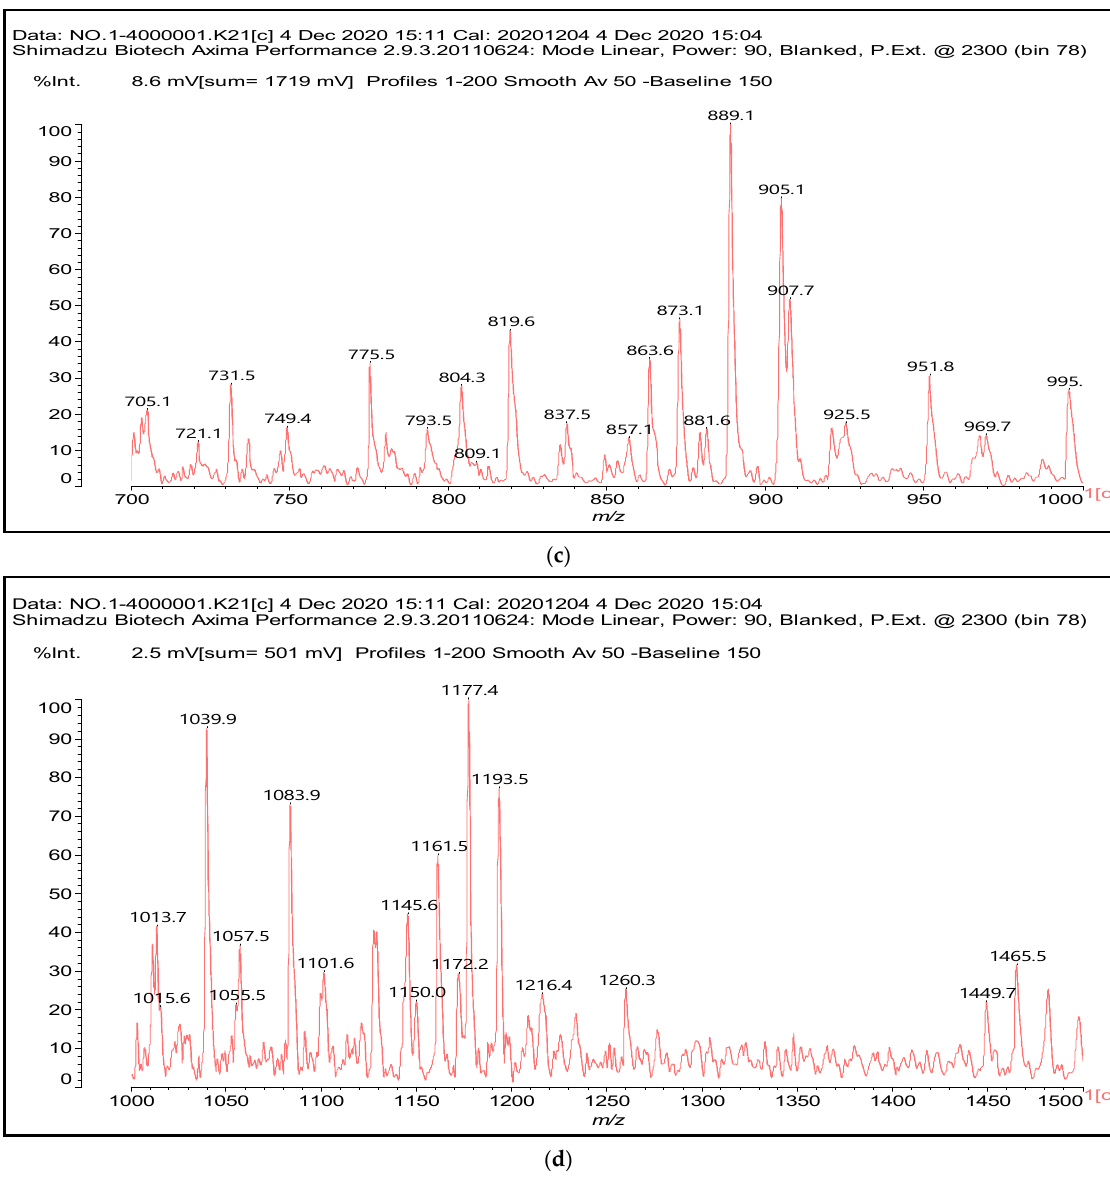
Figure 1. MALDI-ToF spectra of tannin-ISP adhesive.( a ) 100 – 300 Da range. ( b ) 300 – 500 Da range. ( c ) 700 – 1000 Da range. ( d ) 1000 – 1500 Da range. Table 1. Assignment of structures to relevant MALDI-ToF peaks fro m Figure 1 (a to d).